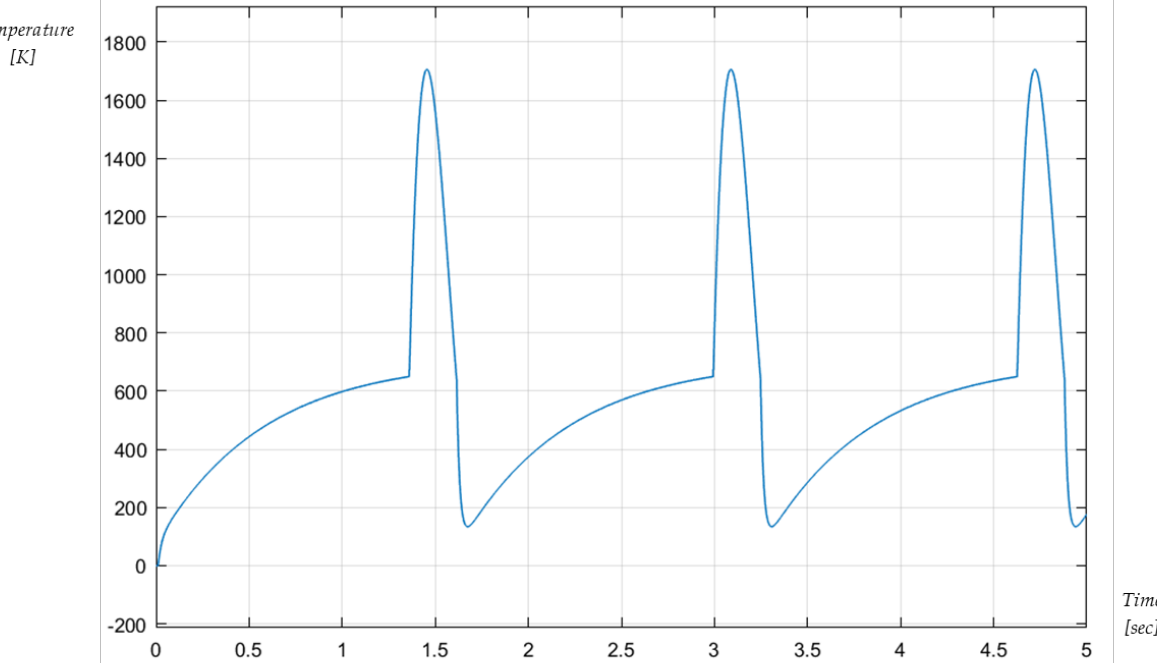
Figure 9. Gain controller applied in a thermal manufacturing process modelled as a switched system: tracking efficiency.